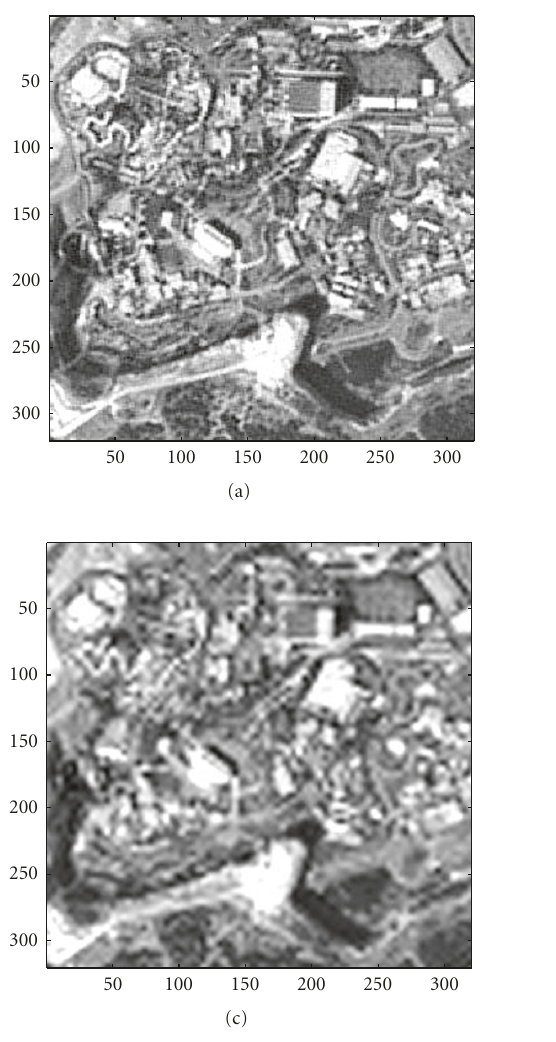
Figure 2(c). The output of the joint MAP SR-NUC